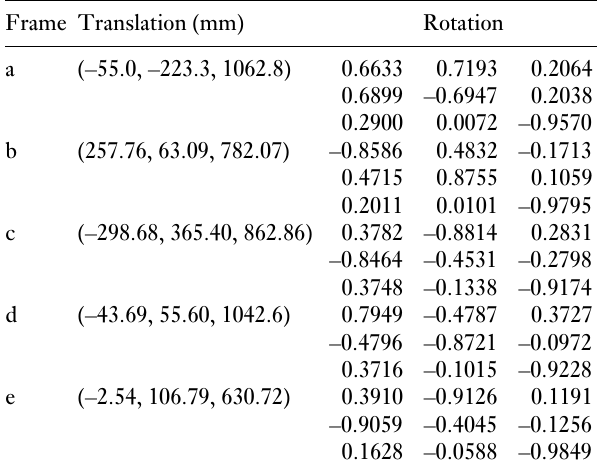
Figure 14 The pose of five frames present in world